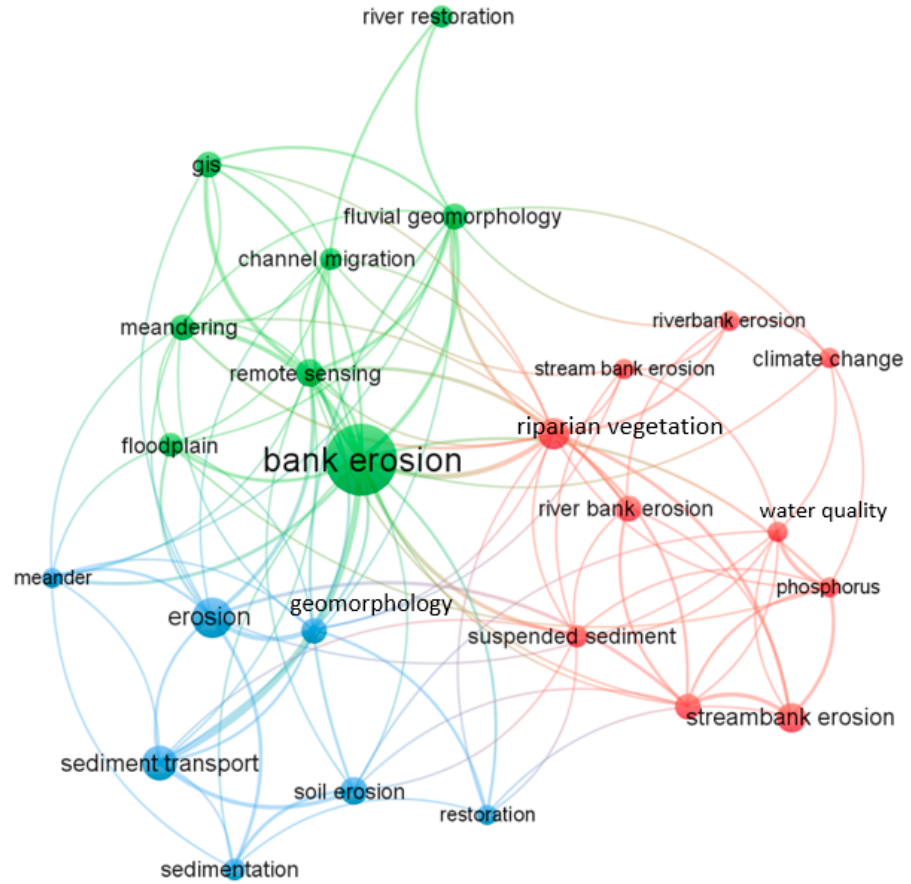
Figure 2. Distribution of keyword occurrences in the relevant literature.